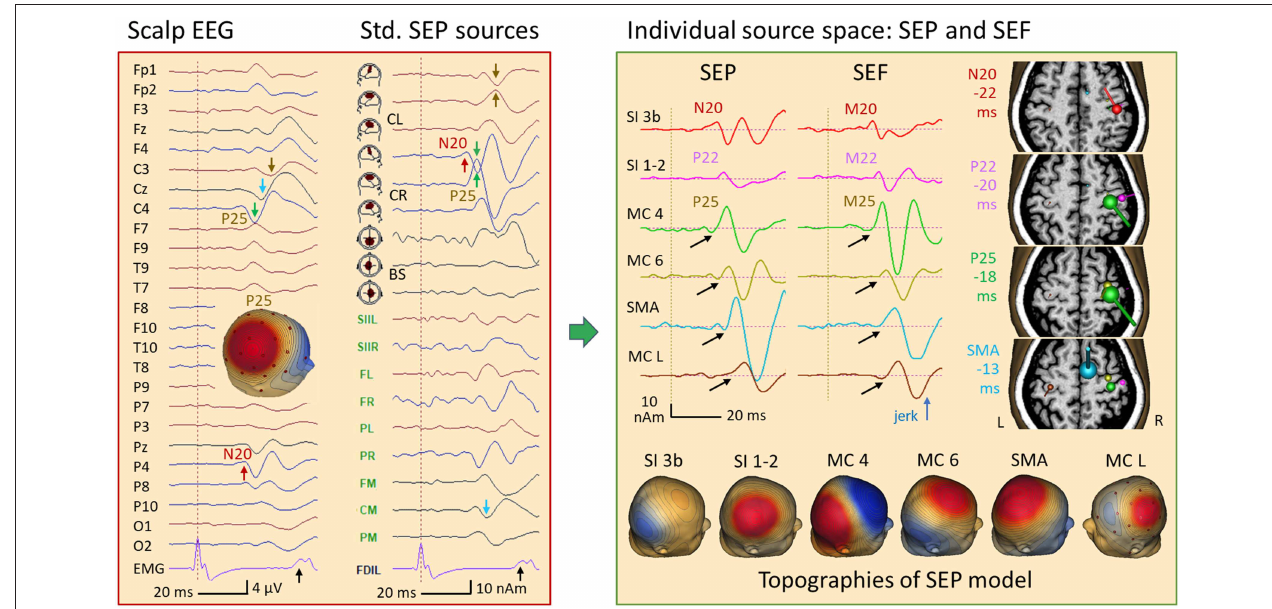
FIGURE 15 | Left median-nerve SEP in a case of myoclonic epilepsy. Left: SEP average in AV25 montage and in SEP source space. Following a weak N20 (P4, red arrow), the giant P25 (28) is seen at C4 (green arrow) and P4. The EMG showed a jerk ∼ 40ms after stimulation of the left hand and, a weaker jerk of the right hand ∼ 10ms later. In SEP standard source space, the regional source CR (below C4) displays the N20 in the 1st trace, perpendicular to the central sulcus. Then, it shares the huge P25 component with the radial 2nd source trace of CR (green arrows), resulting in the strong positive peak of P25 between C4 and P4 in the scalp map. A similar giant P25 pattern is seen ∼ 10ms later in the left central region (CL, brown). Right: an MDS model with 6 dipoles resolved the complex overlap both in EEG and MEG (for details see text): N20 (red) is followed by the more radial post-central P22 (pink), by the pre-central P25 (shared by 2 sources in MC 4, green and MC 6, yellow) and activities in SMA (blue) and the contralateral, left motor cortex (MC L, brown). The peak times relative to the left-hand jerk are given next to the MRI slices used to display MEG dipole orientations and strengths at the peak times of N20, P22, P25, and SMA. Below, the 6 forward EEG topographies of the MDS are depicted. Using their inverse matrix, the 32 scalp EEG channels and, independently, the 122 MEG channels could be taken back into the brain to separate the activities of the nodes of the network underlying this case of myoclonic epilepsy. Black arrows indicate the onset of the later activities that had no obvious cross-talk with the earlier